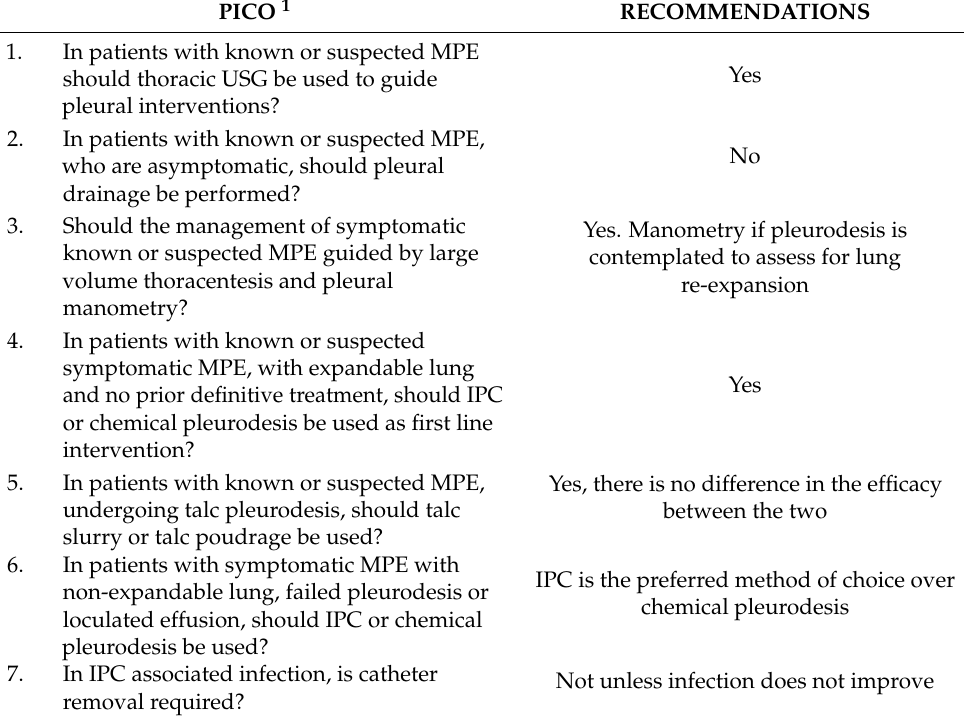
Table 1. Summary of Current recommendations of ATS/STS/STR